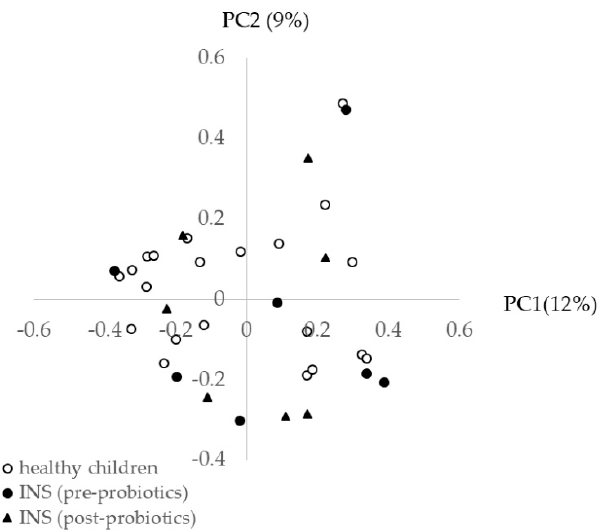
Figure 2. Principal coordinate (PC) analysis of the gut microbiota of healthy children and children with idiopathic nephrotic syndrome (INS) before and after probiotic treatment. There were no differences between the three groups. There was also no difference in clusters before and after probiotic treatment.